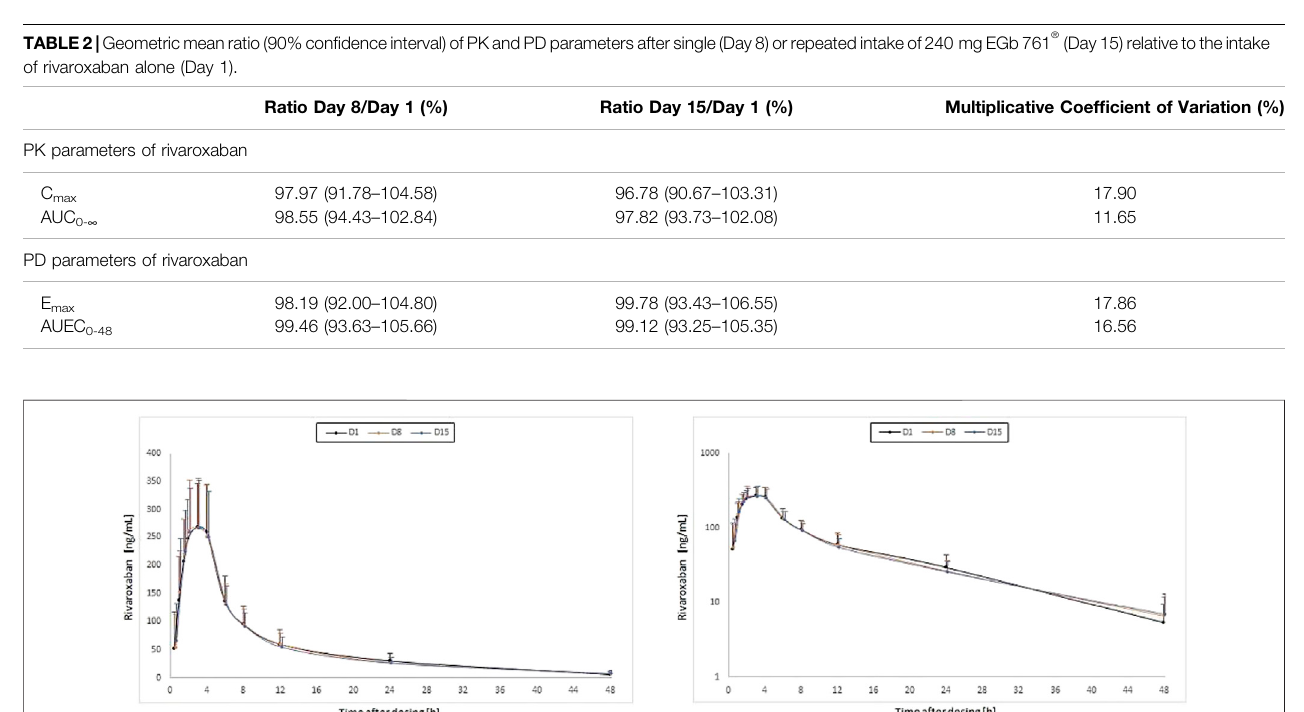
Pro fi ling day